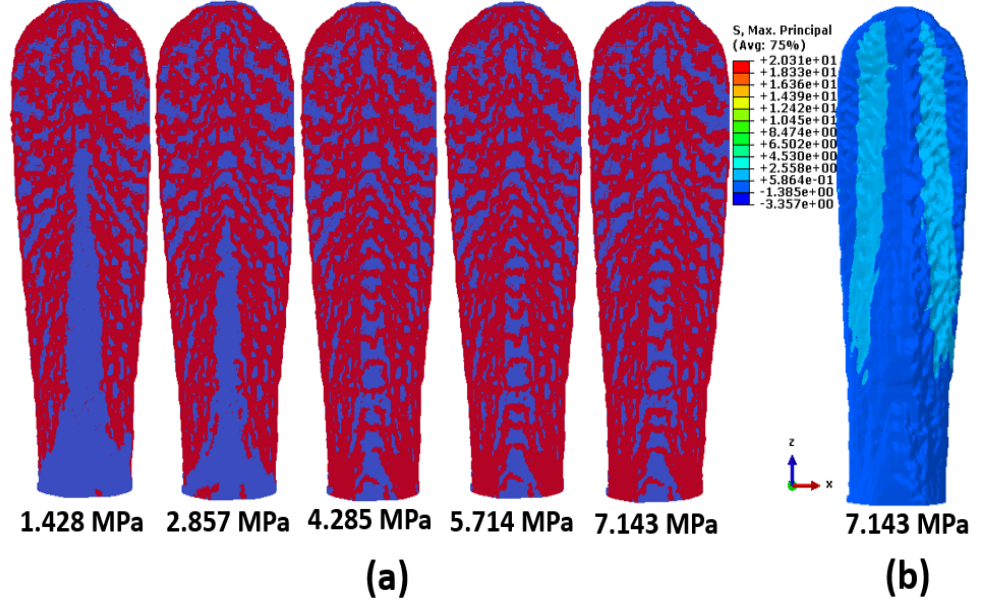
Figure 18. Tissue of paddlefish rostrum. ( a ) Network flow analysis on the bottom surface of rostrum subjected to uniform pressure loading with a fixed plate boundary condition. Nodes are colored by their respective locations on the source (red) or sink (blue) side of the minimum cut. ( b ) Maximum principal stresses on the bottom surface of rostrum.